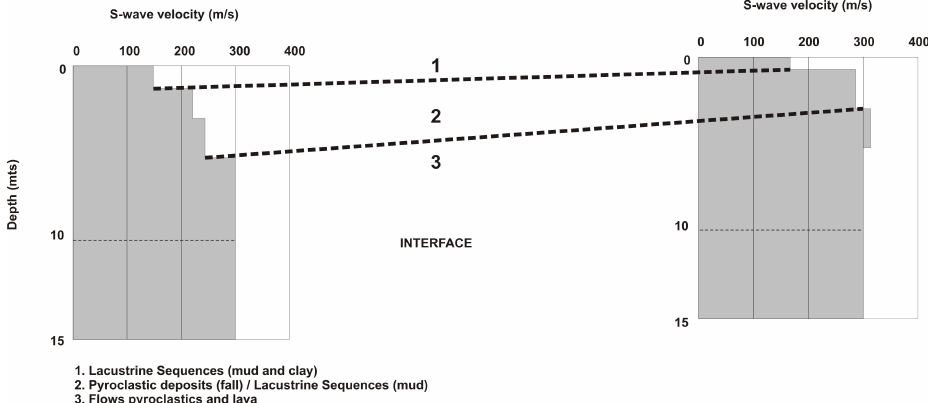
Figure 5. 1-D S-Wave velocities model from the 2-D MASW Method showing a 15m depth of investigation. Three layer according to the shear velocities were identified (1) lacustrine clays, (2) sand, volcanic ashes; (3) volcanic flows and fractured lavas.